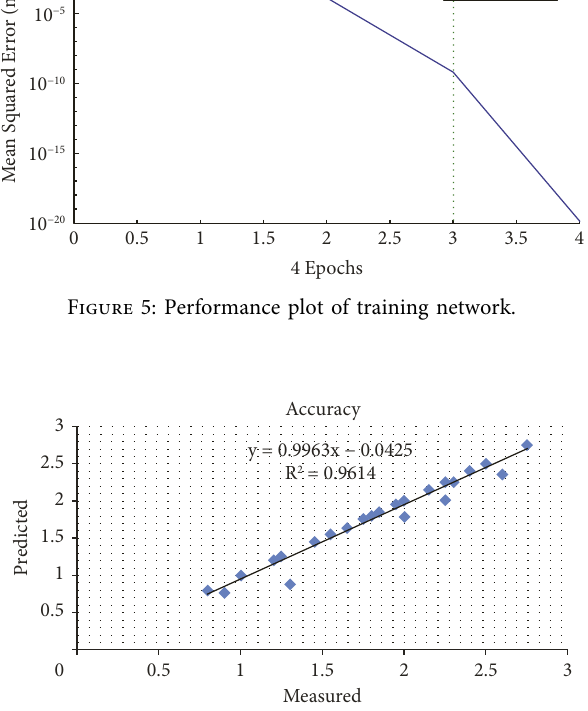
Figure 6: Accuracy plot of NARX network w.r.t target.